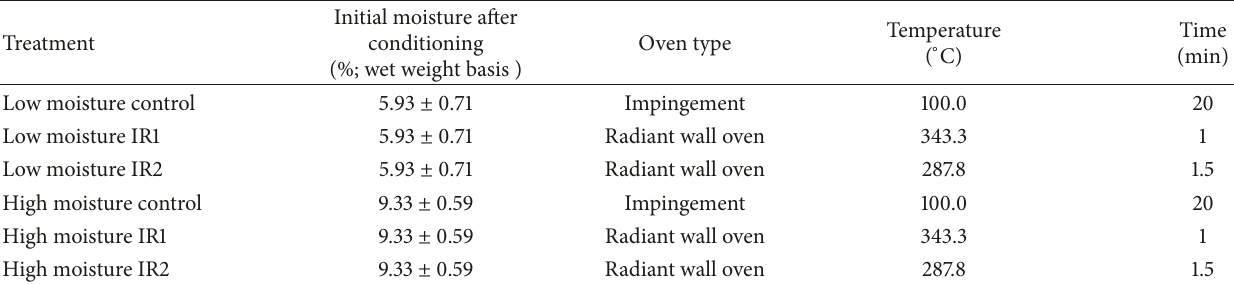
Table 1: Description of blanching treatments (𝑛 = 3) used in the